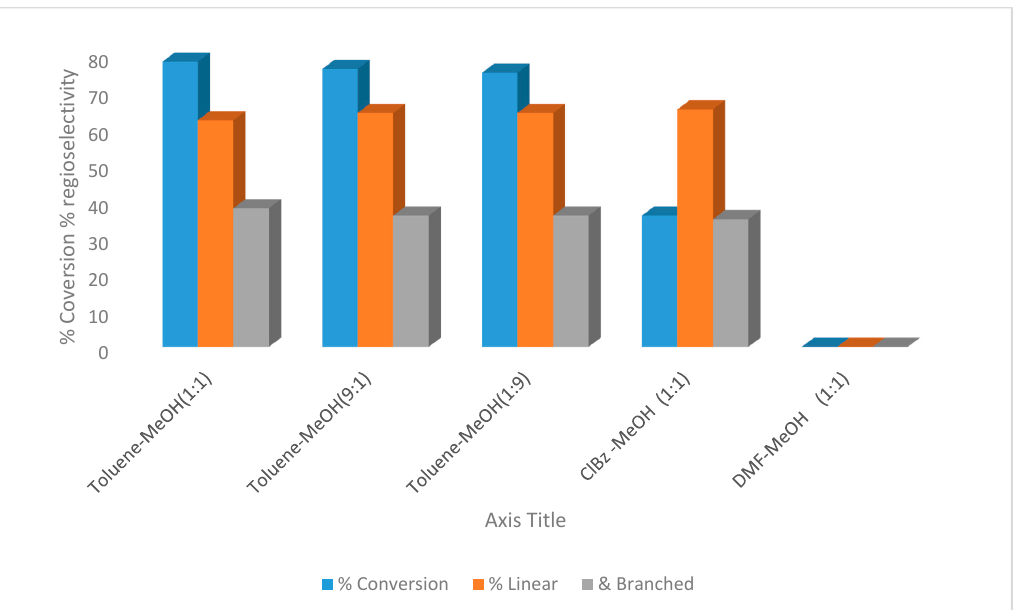
Figure 3. The effect of solvent mixtures in the methoxycarbonylation of 1-hexene. The reaction conditions were time, 24 h; P CO : 60 bar; temperature, 90 °C; solvent, methanol/toluene (100 mL) complex 2 (0.5% mol); and PPh 3 :PTSA:1-hexene ratio, 1:5:100.